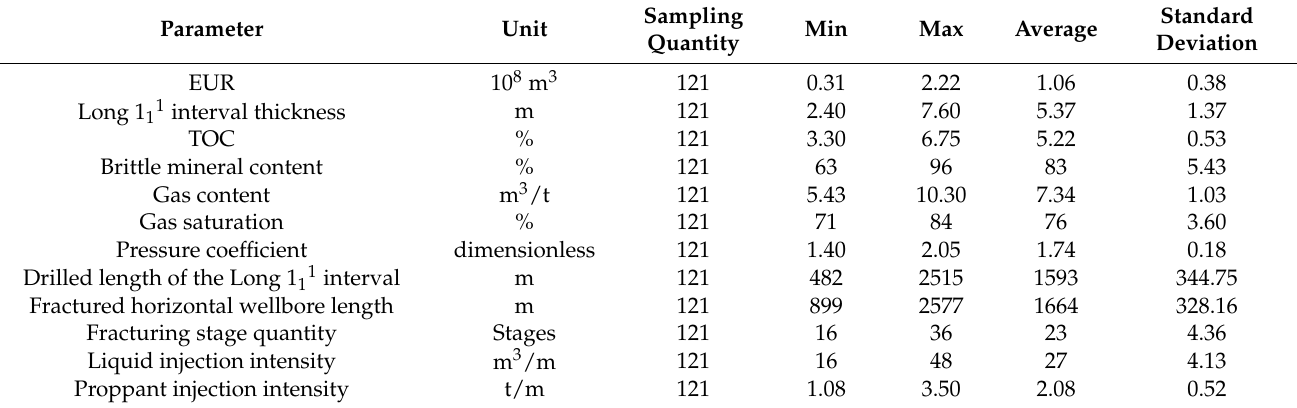
Figure 2. Probability distribution of the EUR of the 121 sample wells. Table 1. Parameter statistics of the sample wells of the Weiyuan shale gas